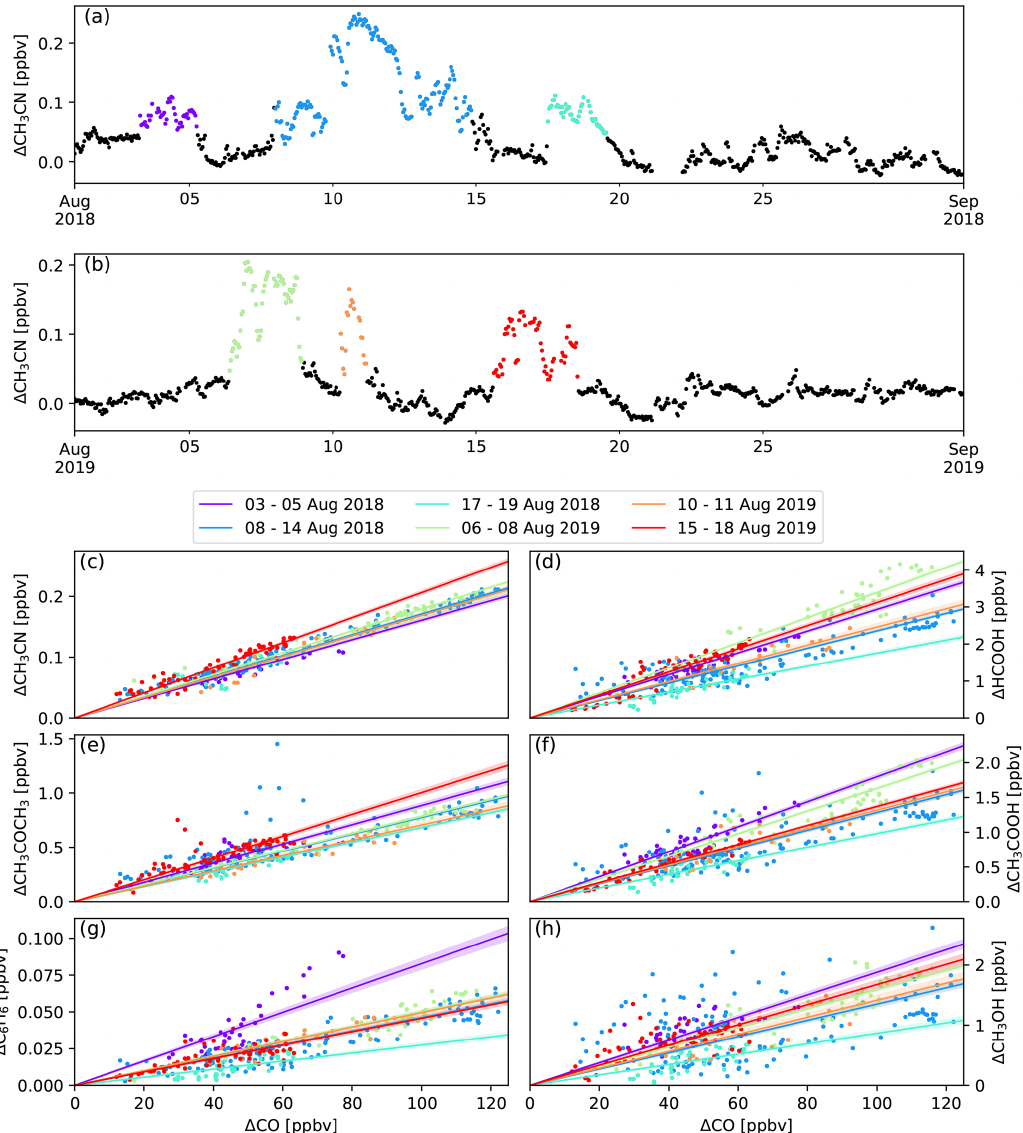
Figure 1. Panels (a) and (b) show the six BB intrusions identified using (cid:49) CH 3 CN (purple: 3–5 August 2018, blue: 8–14 August 2018, cyan: 17–19 August 2018, green: 6–8 August 2019, orange: 10–11 August 2019, red: 15–18 August 2019). The bottom six panels show the EnR fits for CH 3 CN (c) , HCOOH (d) , CH 3 COOH (e) , CH 3 COCH 3 (f) , C 6 H 6 (g) and CH 3 OH (h) . EnRs are normalised to the excess mixing ratio of CO for the six intrusions in the colours used in panels (a) and (b) . Uncertainty in the linear regression is shown as a coloured band around the